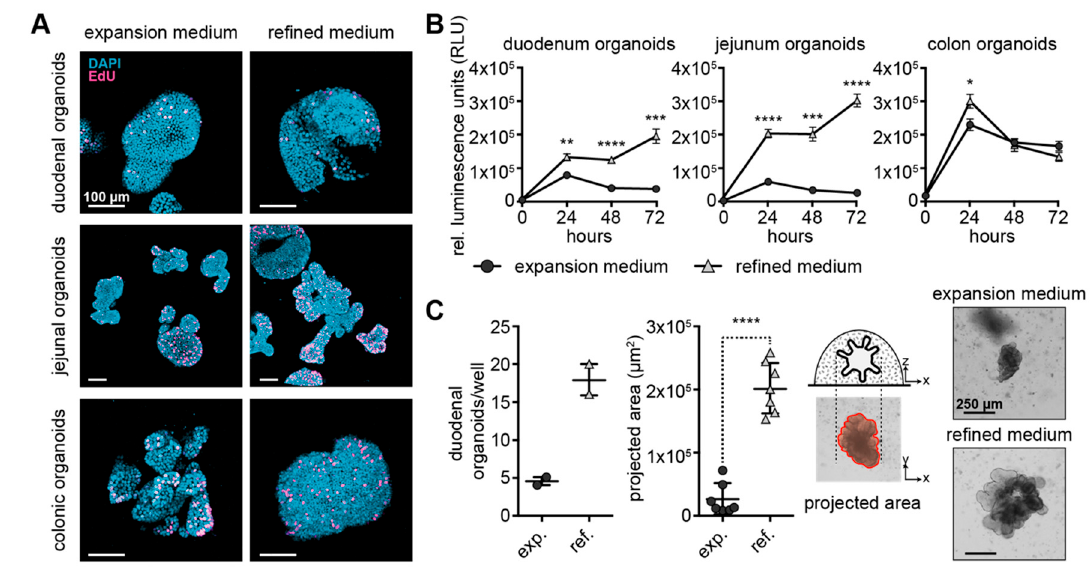
Figure 4. Derivation of organoids is more efficient using refined medium conditions. ( A ) 3D reconstruction of confocal z-stack images from duodenal, jejunal and colonic organoids in expansion and refined medium; staining for EdU after one hour labeling (magenta); organoids counterstained using DAPI (blue); scale bar represents 100 µm. ( B ) Relative luciferase activity of cell viability assay is shown for serial measurements at 0, 24, 48 and 72 h after addition of substrate to duodenal, jejunal and colonic organoids in expansion (circle) and refined medium (triangle); mean is shown; whiskers represent SEM; * p < 0.05, ** p < 0.01, *** p < 0.001 and **** p < 0.0001; 50 organoids seeded per replicate; n = 6 replicates. ( C ) Organoid number is shown for freshly isolated duodenal biopsies seeded in expansion and refined medium, in scatter dot plots with mean and range indicated by whiskers, n = 2 wells; projected area of organoids is depicted with mean and SEM defined by whiskers, **** p < 0.0001, n = 7 organoids; bright field images of representative organoids are shown, scale bar represents 250 µm.